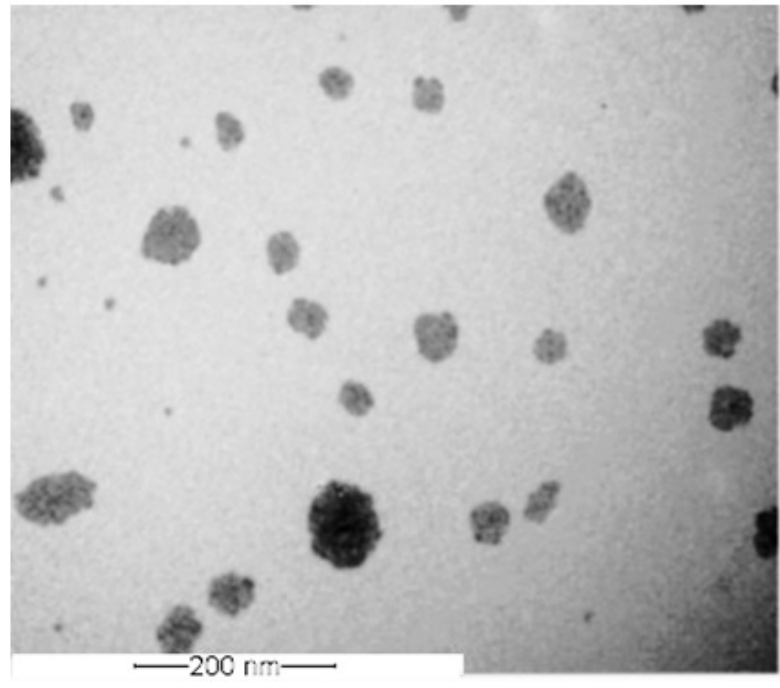
Figure 4. TEM images of optimized NEs (ANE4).